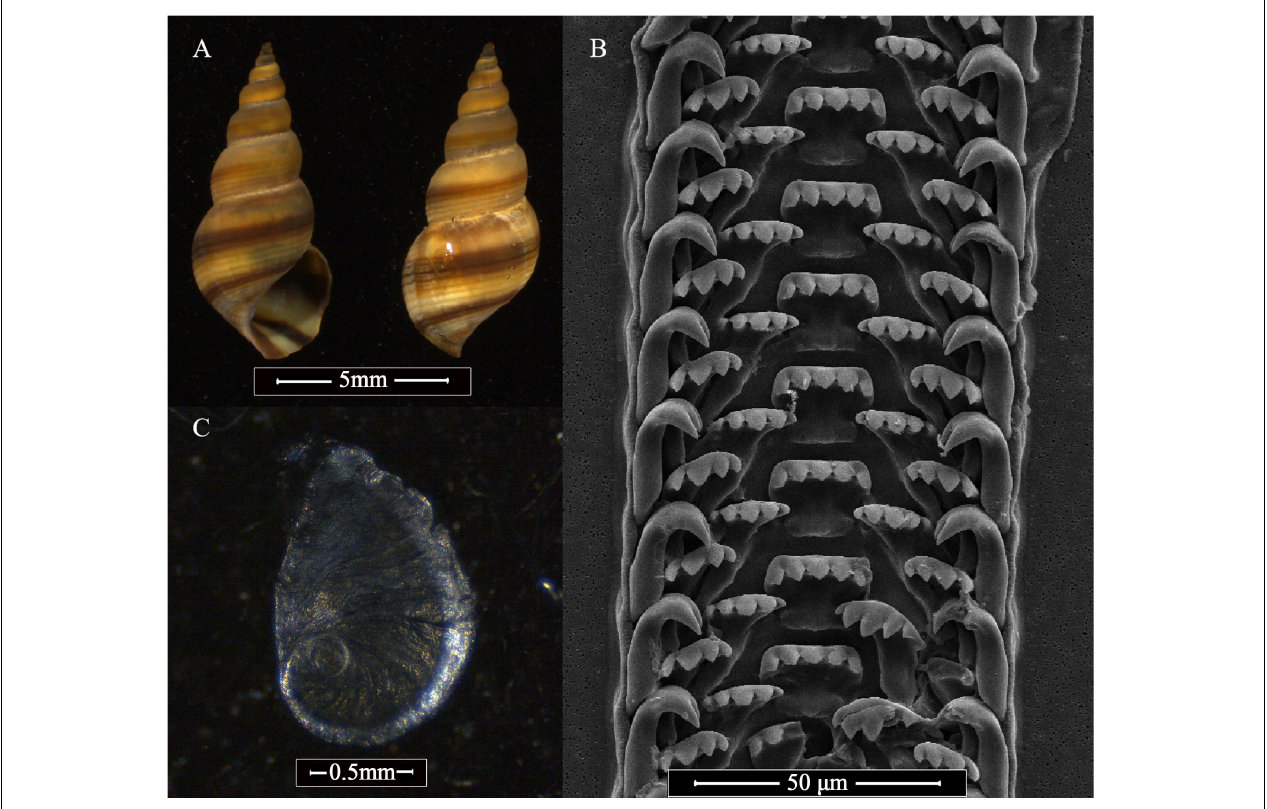
FIGURE 2 | Shell shape (A) , rachidian tooth (B) , and operculum (C) of Mainwaringia leithii collected from rehabilitated mangroves in the present